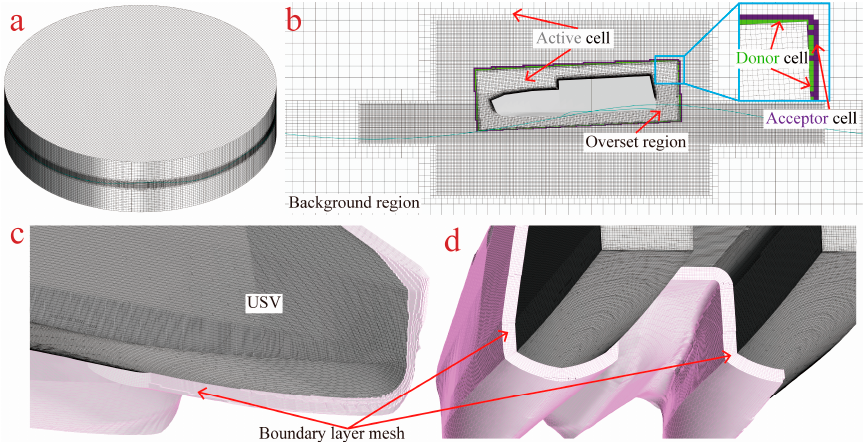
Figure 6. Computational mesh: ( a ) overall meshes of the computational domain, ( b ) overset mesh and local mesh refinement of the free surface, overlap area, ( c , d ) meshes around the hull and boundary layer mesh.